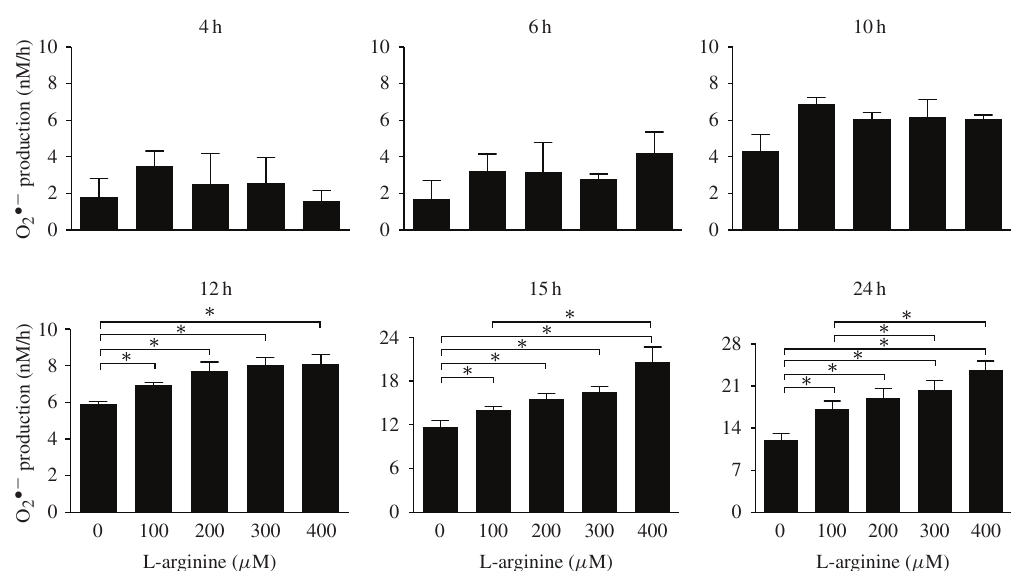
•− production in LPS-stimulated RAW 264.7 •− was determined in the cell